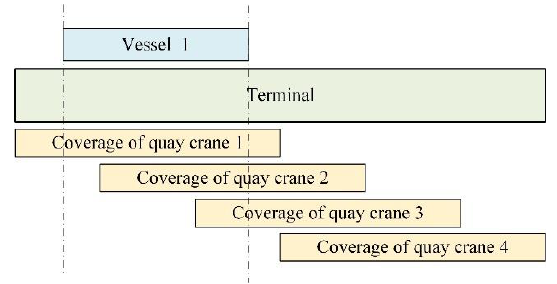
Figure 3. The coverage of quay cranes. (Source: compiled by the authors).